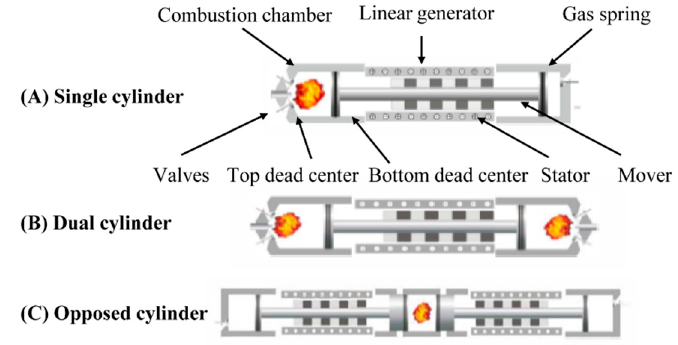
Figure 1. Illustration of the principle of the free-piston linear generator [2,12].